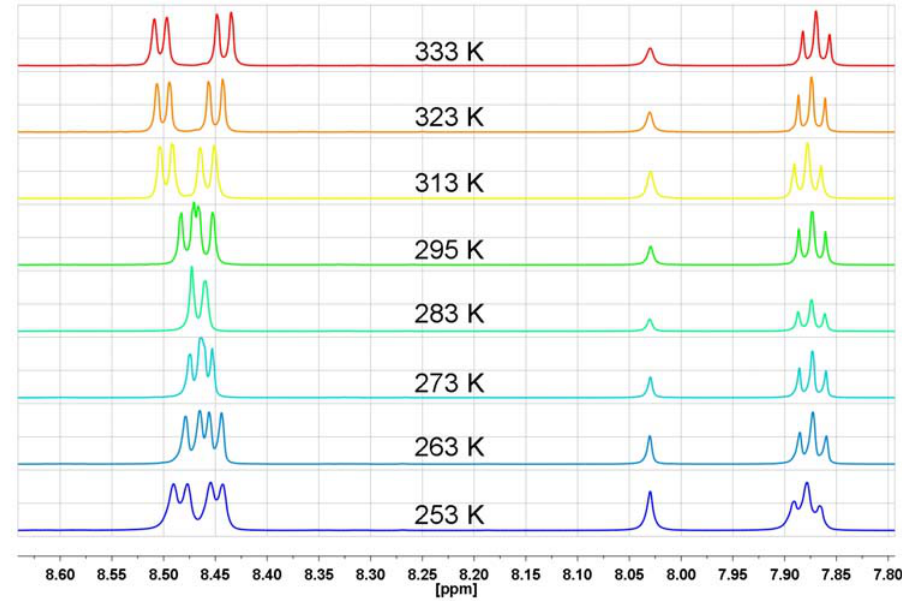
Figure 5. The range of aromatic protons of 1 H-NMR spectrum in DMF-d N,N -bis[3-(1,8-naphthalimido)propyl]- N -propylamine at different temperatures ( NP5 ).